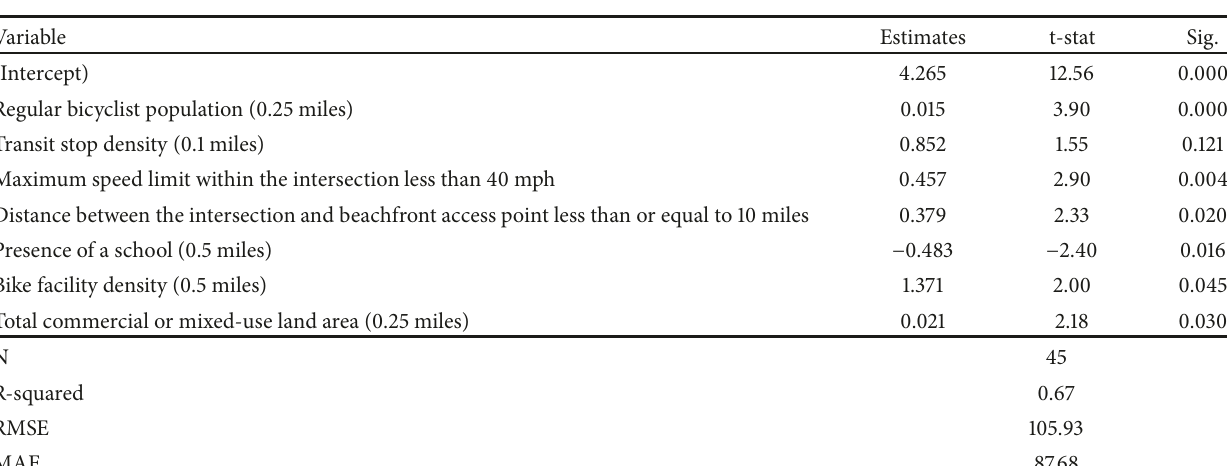
Table 2: Negative binomial regression model for